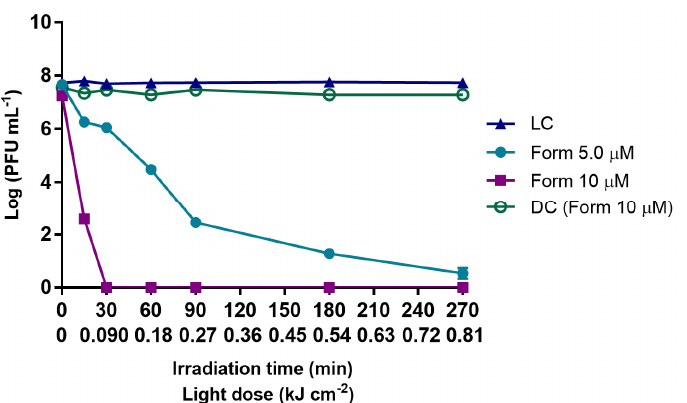
Figure 1. Inactivation of T4-like bacteriophage during aPDT, in PBS, with Form at 5.0 and 10 µ M, for 270 min of irradiation with artificial white light (50 mW cm − 2 ). The values are expressed as the mean of three independent experiments with two replicates; error bars represent the standard deviation (SD) between the experiments. In some cases, SD bars are covered behind the symbols and lines join the experimental points.